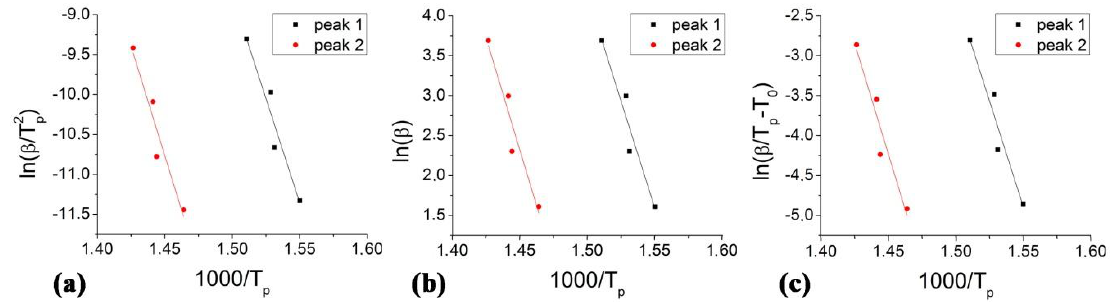
Figure 5. ( a ) Kissinger plot of the Al 82 La 10 Fe 4 Ni 4 amorphous powder. ( b ) Ozawa plot of the Al 82 La 10 Fe 4 Ni 4 amorphous powder. ( c ) Augis-Bennett plot of the Al 82 La 10 Fe 4 Ni 4 amorphous powder.